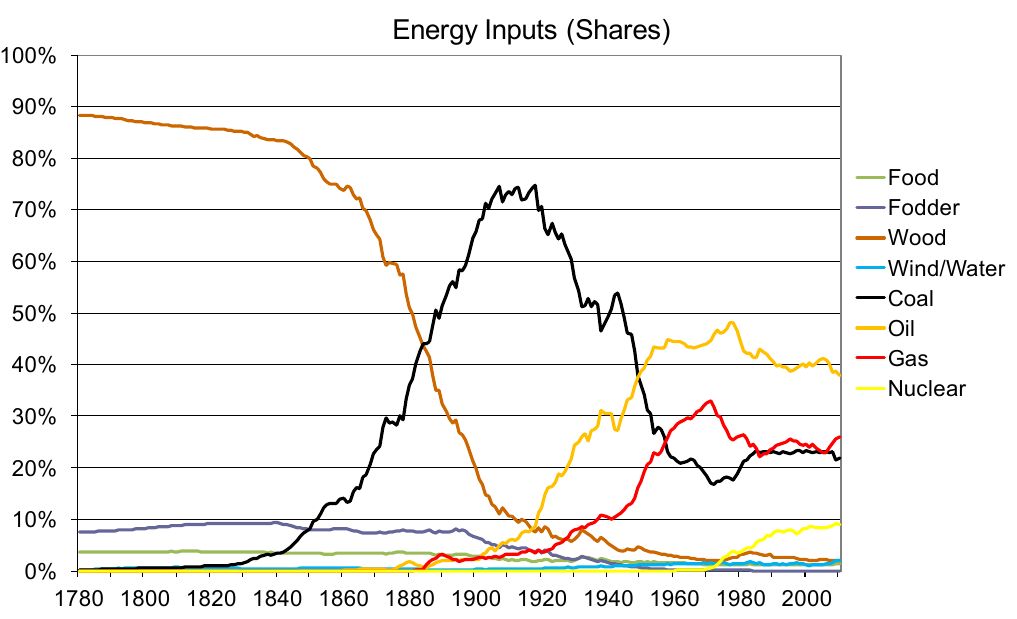
Figure 14. Shares of inputs to U.S. energy consumption, 1780–2010. Sources: various; see individual energy series in Section 2.